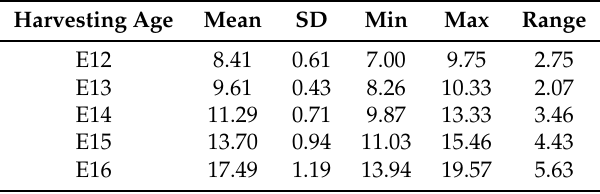
Table 1. Summary statistics for crown–rump length.